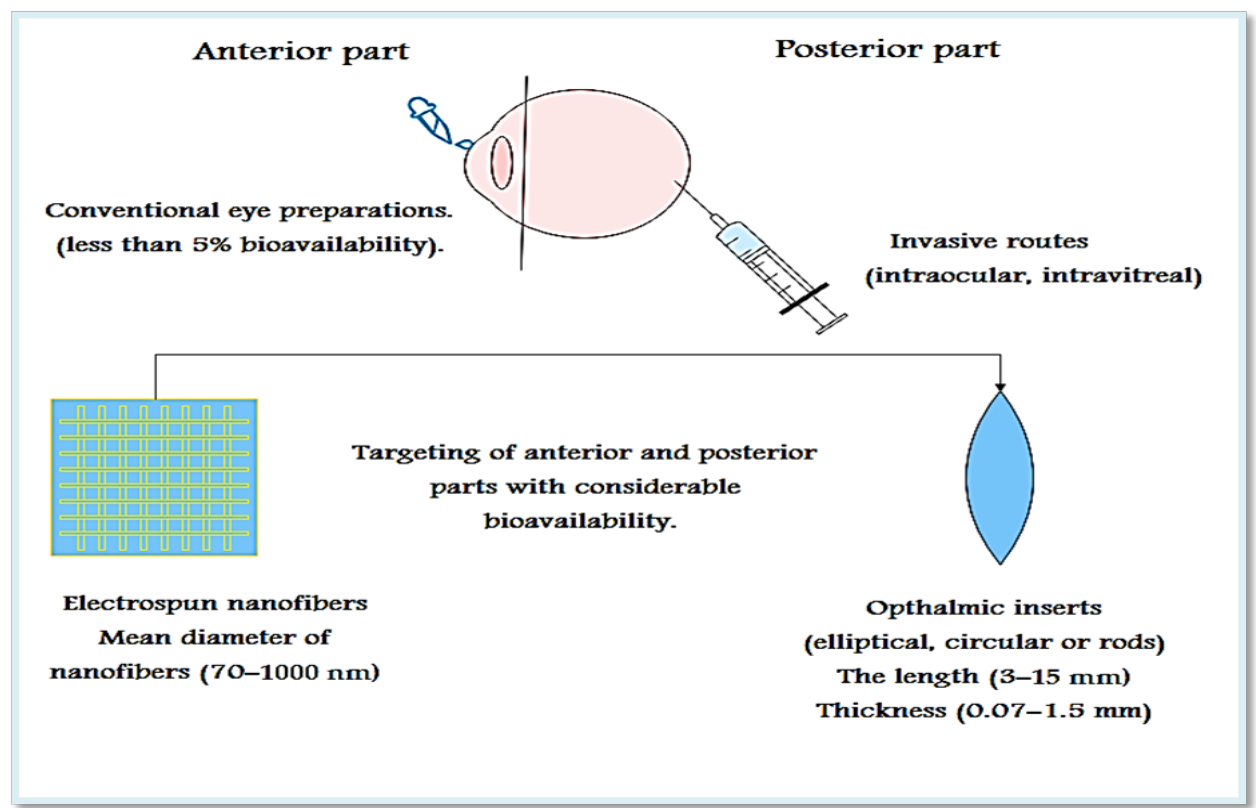
Figure 1. The most common routes of targeting different parts of the eye.